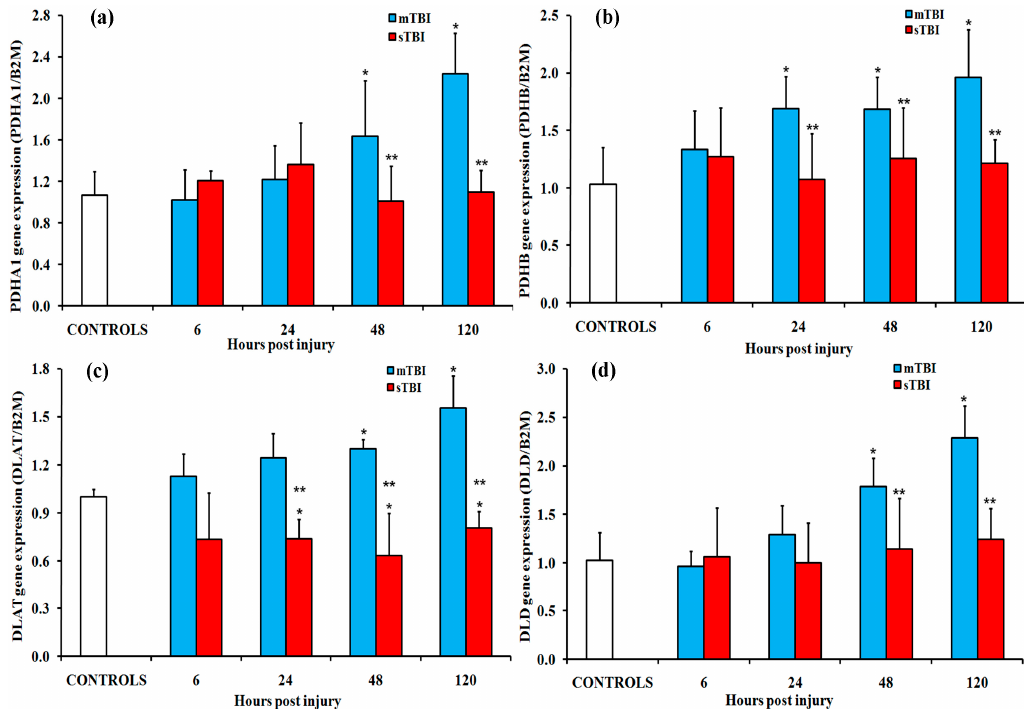
Figure 1. Changes in the expression of genes encoding for the different subunits of the pyruvate dehydrogenase (PDH) complex in brain tissue homogenates of rats receiving traumatic brain injury TBI of different severities (mild (m)TBI or severe (s)TBI), at various times post-injury. ( a ) Pyruvate dehygrogenase E1 alpha (PDHA1) and ( b ) pyruvate dehygrogenase E1 beta (PDHB) genes encoding for the E1 subunits; ( c ) the dihydrolipoamide-S-acetyltransferase (DLAT) gene encoding for the E2 subunit; ( d ) dihydrolipoamide dehydrogenase (DLD), gene encoding for the E3 subunit. Values are the mean of six animals. Standard deviations are represented by vertical bars. Gene expressions were calculated relatively to the expression of the housekeeping gene β -2-microtubulin (B2M). * significantly different from controls, p < 0.05. ** significantly different from the corresponding time of mTBI rats, p < 0.05.